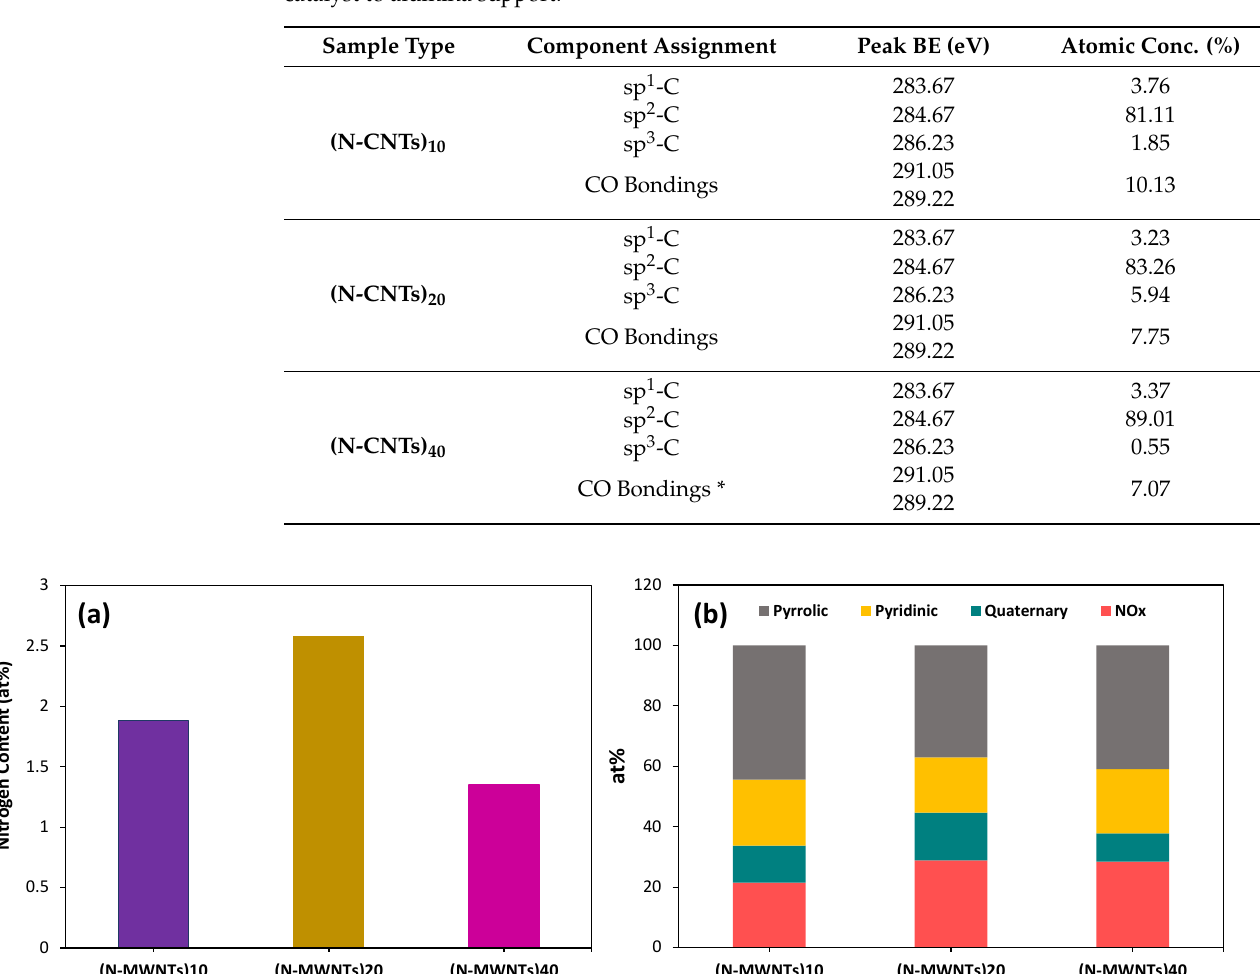
Table 1. XPS peak positions data for C1s line of N-MWNTs synthesized using different ratios of iron